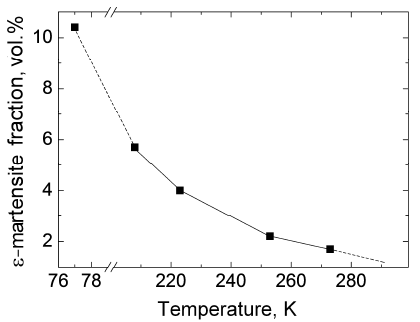
Figure 5. Stress-induced ε -martensite volume fractions vs. test temperatures.